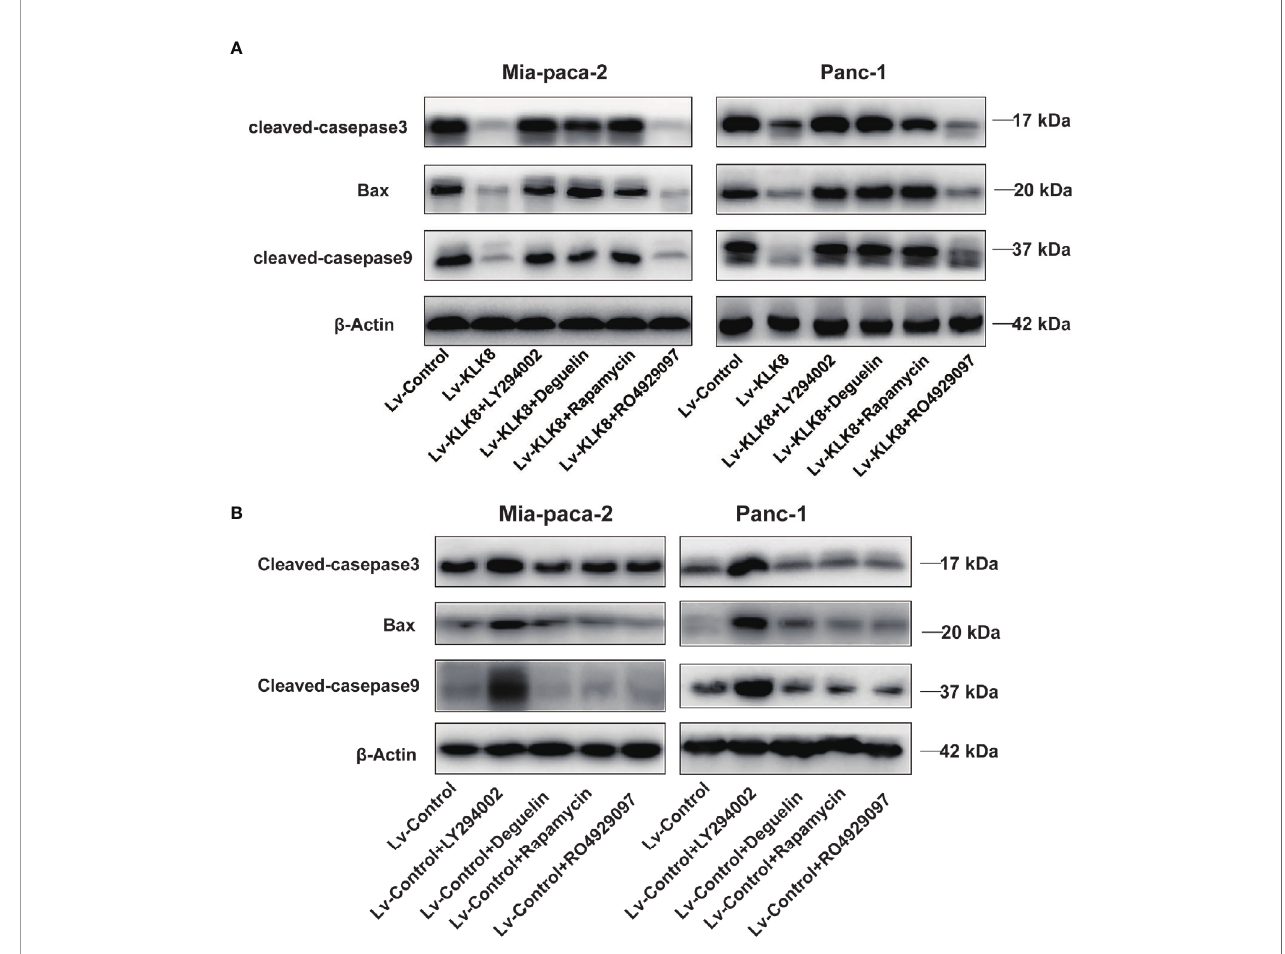
FIGURE 8 | KLK8 decreased protein levels of pro-apoptotic proteins through the activation of PI3K-Akt-mTOR pathway. Mia-paca-2 and Panc-1 cells in Lv-KLK8 (A) and Lv-Control (B) were treated with PI3K inhibitor LY294002(75 m M), Akt inhibitor Deguelin (500 nM), mTOR inhibitor Rapamycin (100 nM) or Notch inhibitor RO4929097 (10 m M). (A, B) protein levels of pro-apoptotic markers cleaved caspase-3, cleaved caspase-9 and Bax were assessed by western